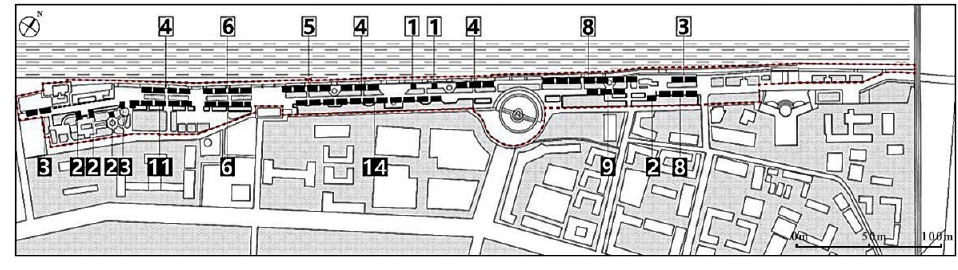
Figure 12. Types and location of leisure square in Harbin’s Stalin Park.